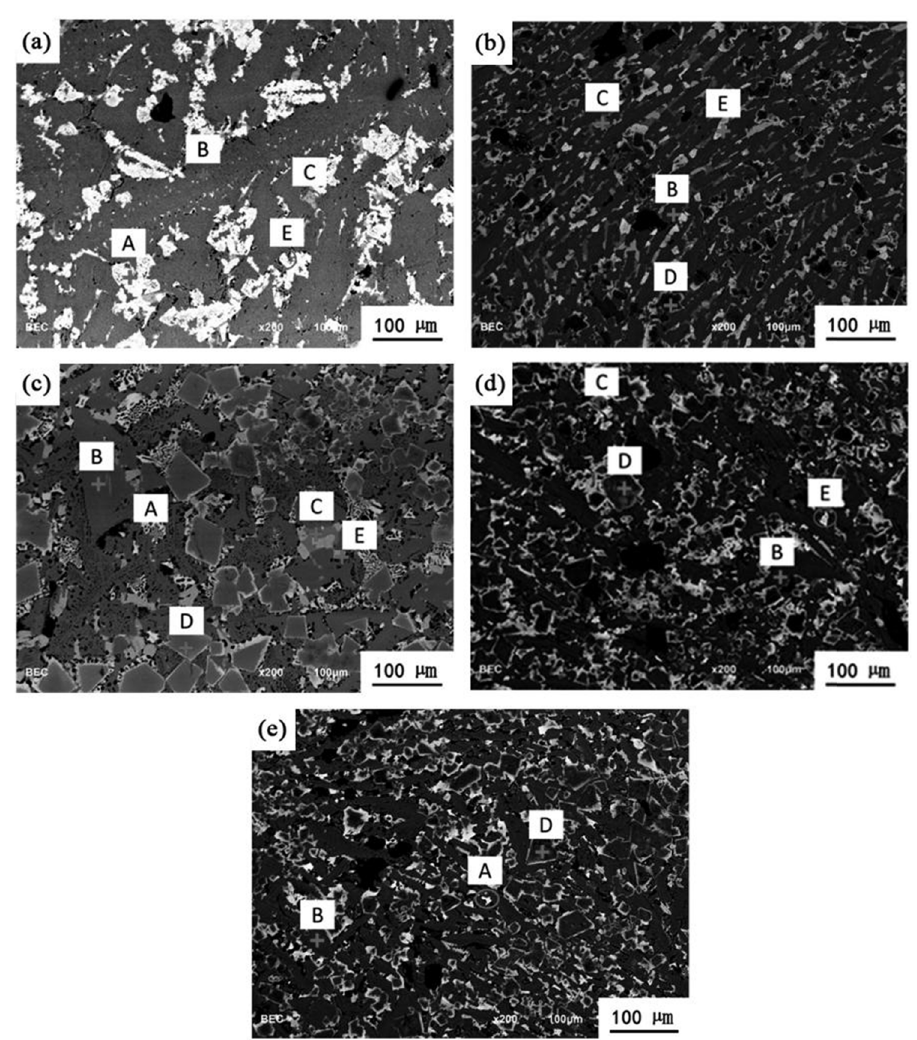
Figure 5: SEM mineral phase composition of mixed slag ( A – MgFe 2 O 4 ; B – Ca 2 Al 2 SiO 7 ; C – Ca 2 SiO 4 - Ca 3 ( PO 4 ) 2 ; D – MgFeAlO 4 ; E – Ca 2 Fe 2 O 5 : ( a ) R = 1.6; ( b ) R = 1.8; ( c ) R = 2.0; ( d ) R = 2.2; ( e ) R = 2.4 )